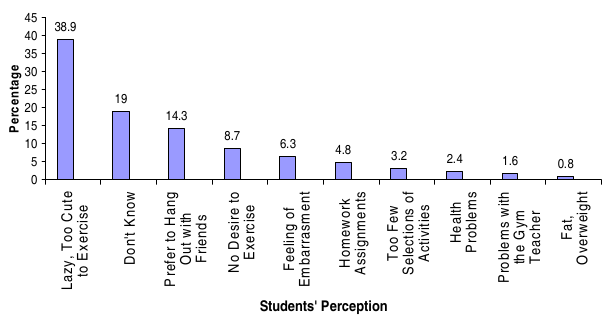
Figure2: Students’ perception of obstacles to